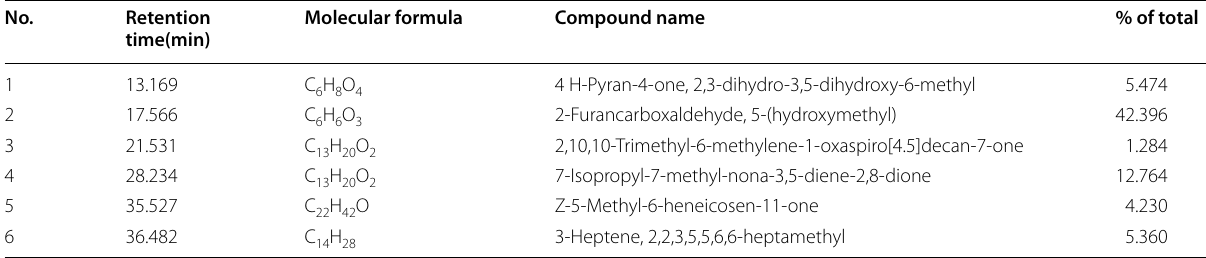
Table 1 The major constituents of the extract of M. communis ethanolic extract (Zadeh et al. 2020) No. Retention